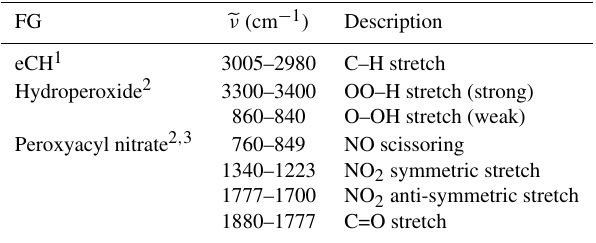
Table C1. Absorption bands in the mid-infrared for vibrational modes present in FGs proposed for Set2 (Sect. 2.3).